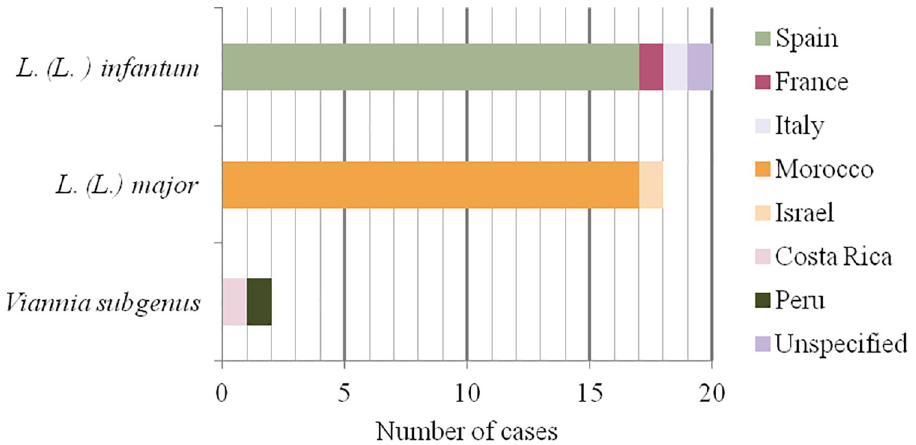
Fig 3. Geographical origins of different Leishmania species.